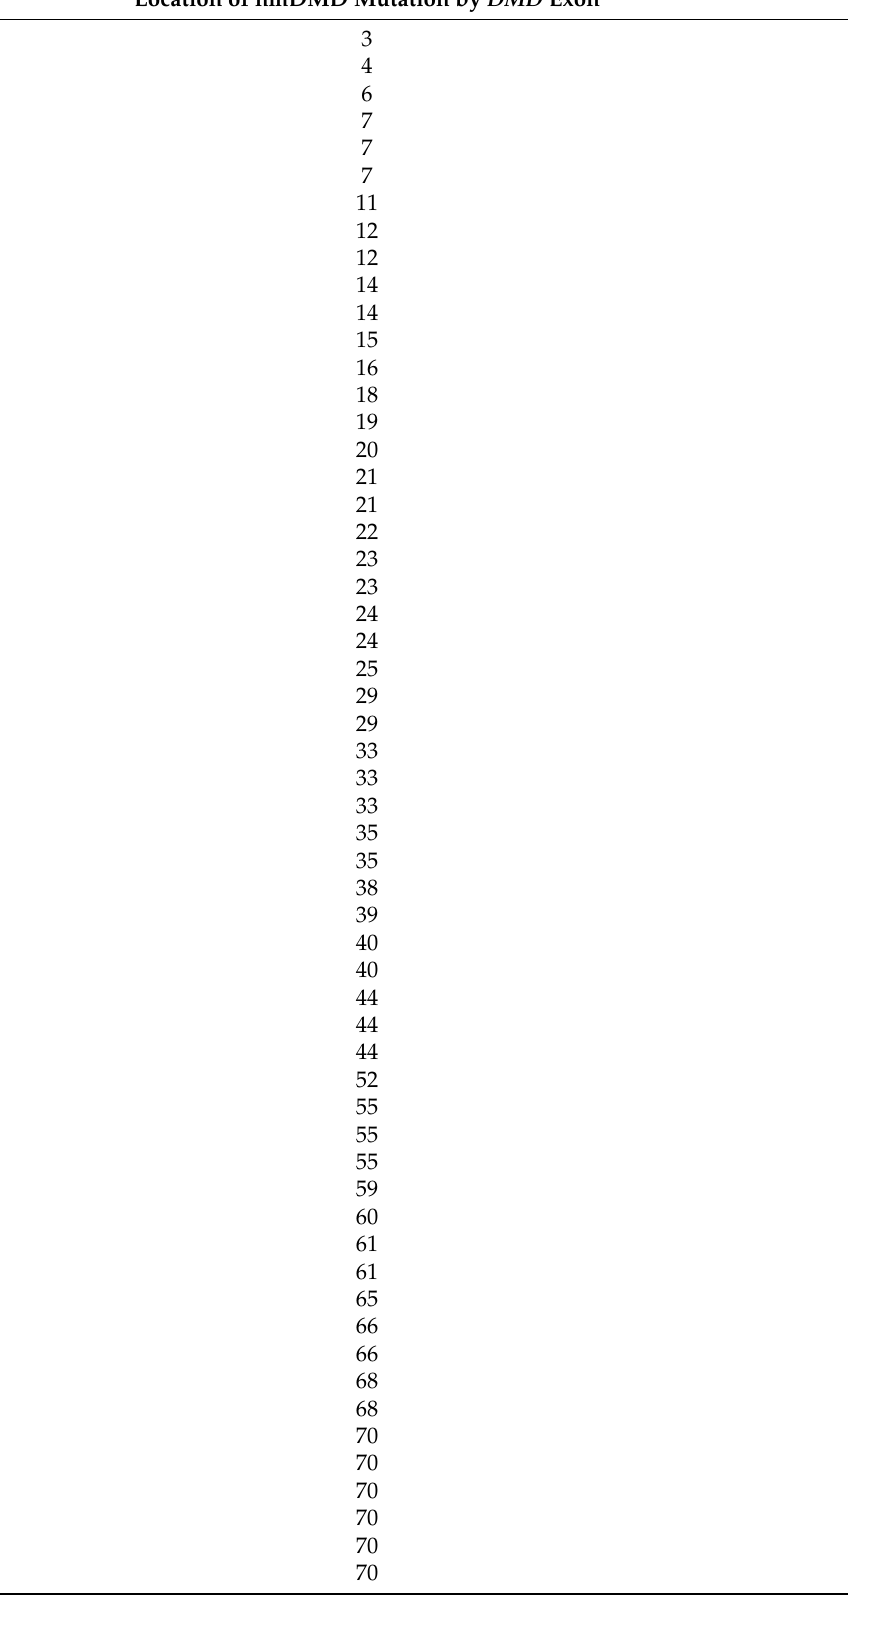
Table 3. The location of nmDMD mutation by the DMD exon is listed. Location of nmDMD Mutation by DMD